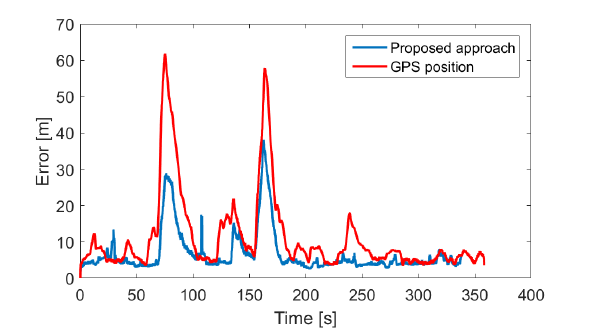
Figure 6. The error of measured GPS position is shown in red and the estimated position error is shown in blue. The results show our proposed approach can significantly improve the position